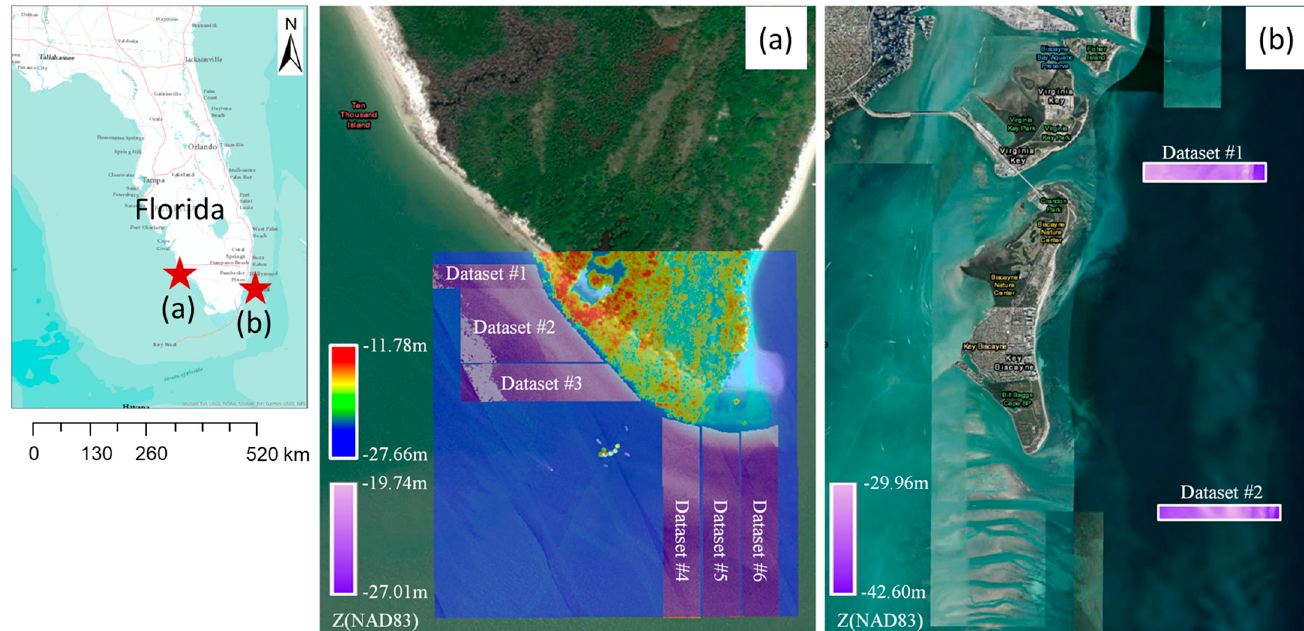
Figure 6. Test sites: ( a ) Marco Island and ( b ) Virginia Key located in Miami, Florida, USA. Table 1. Data set and acquisition parameters. Note that the point densities refer to all returns (e.g., seafloor, water column, and sea surface) and encompass overlapping flight lines. LMSL refers to the local mean sea level tidal datum. Location